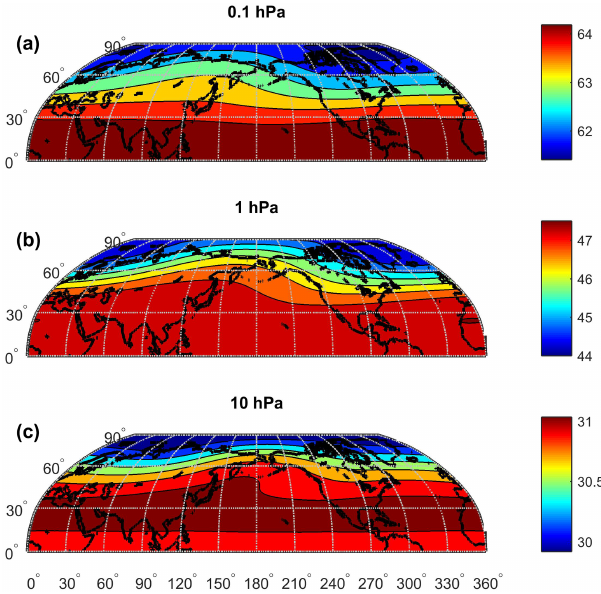
Figure 2. The climatology of meridional wind (scale inms − 1 ) for January at 0.1 (a) , 1 (b) and 10hPa (c) , 1979–2013. Positive values for southerly wind (wind from south), negative values for northerly wind. Horizontal axis, longitude; vertical axis,